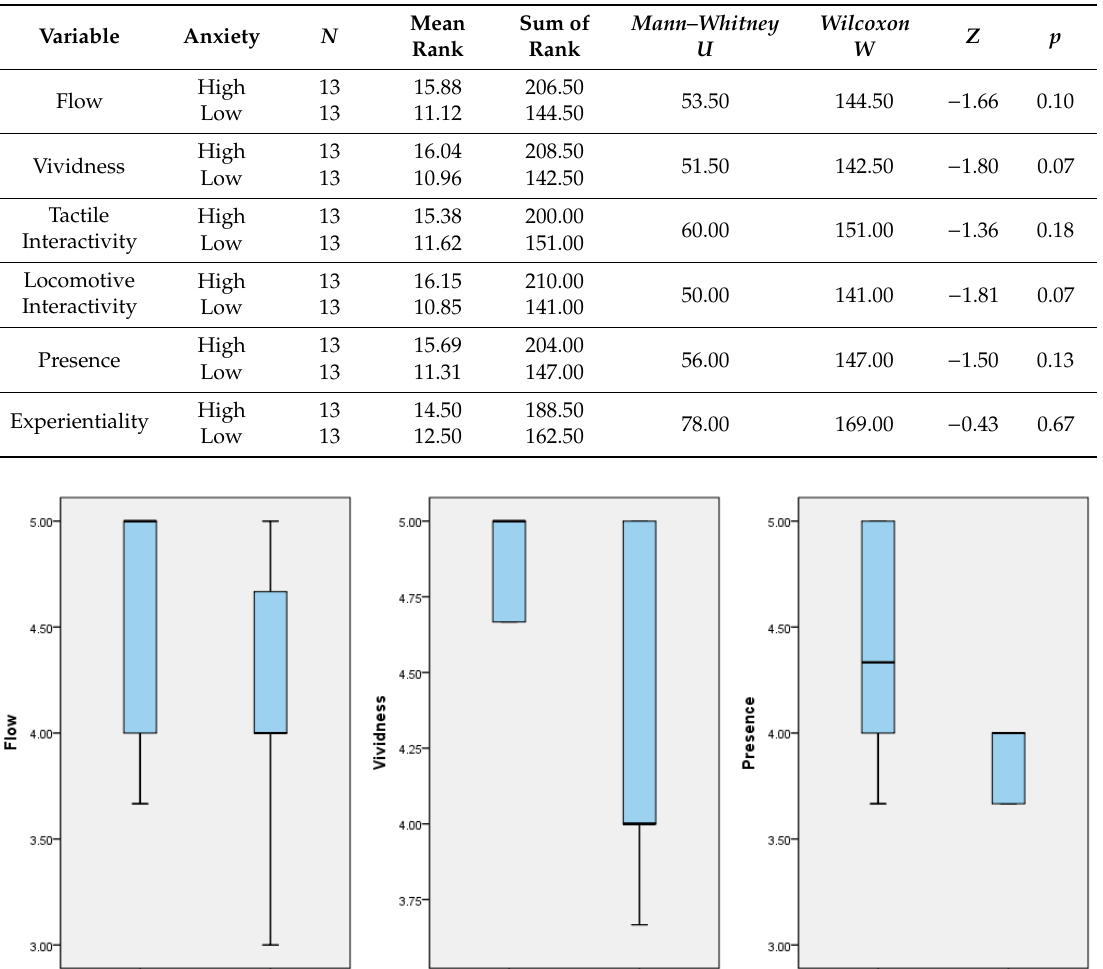
Table 5. Results of the Mann–Whitney U test analysis for the high- and low-anxiety groups for all the variables while playing the fire safety education VR game with cutaneous sensation.